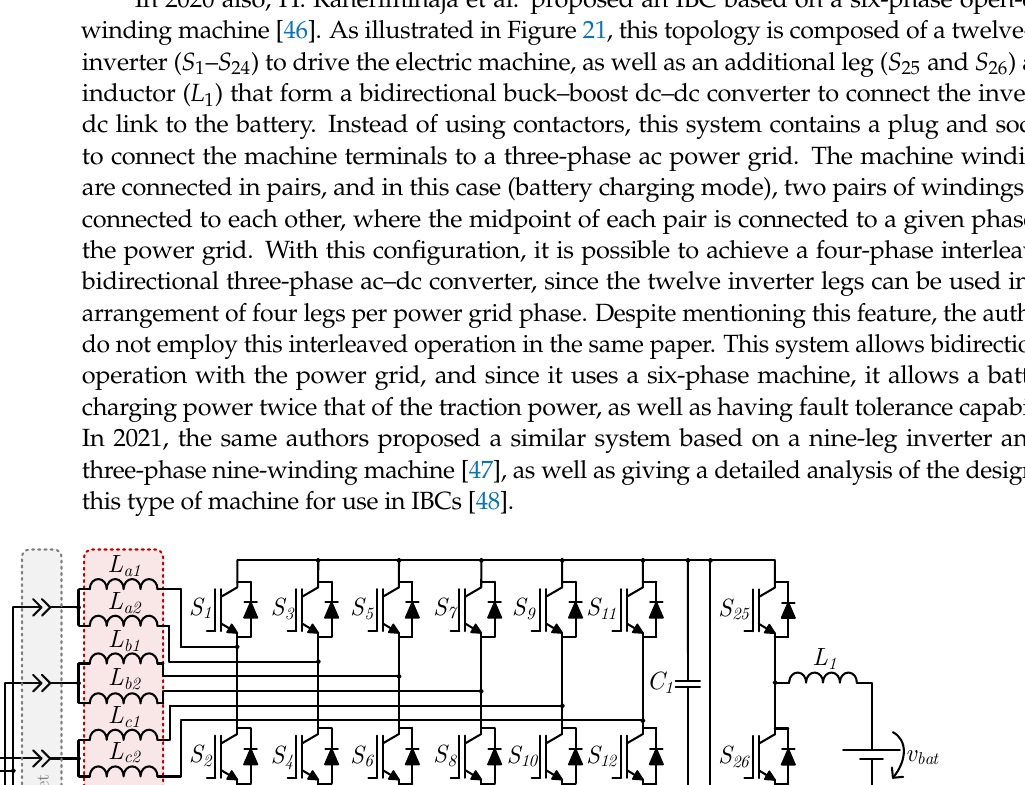
Figure 21. EV IBC proposed by H. Raherimihaja et al. in 2020 [46].